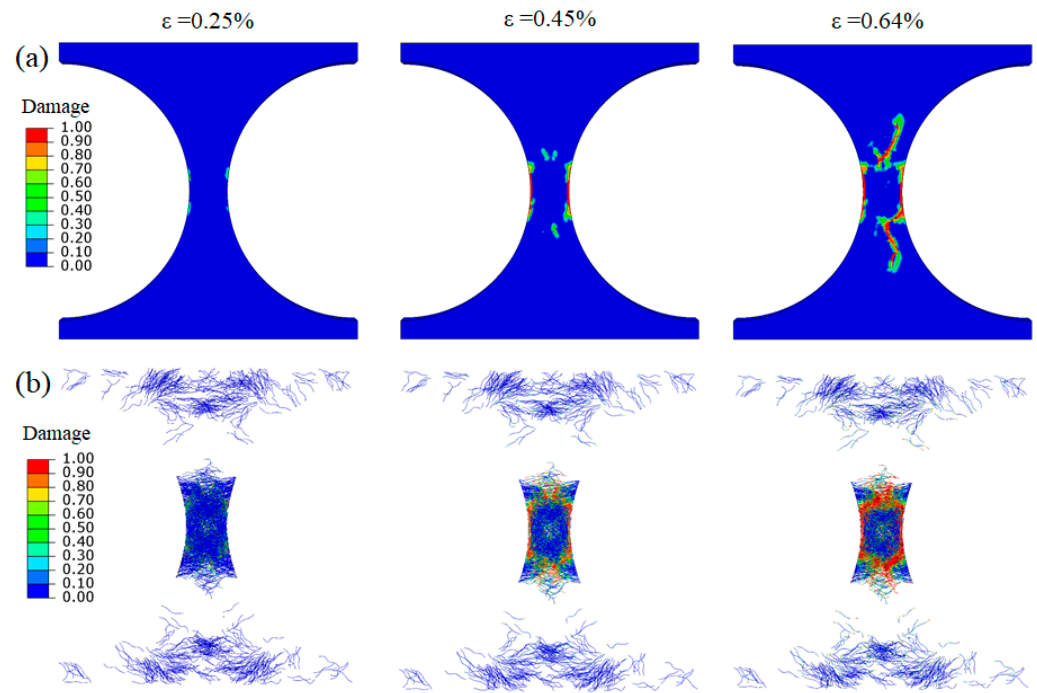
Figure 8. Damage development in the hierarchical FRC reinforced by the optimal CNT networks with a content of 1.0 wt%. Contour plots of the damage variable in ( a ) the matrix and ( b ) at CNT/matrix interface.